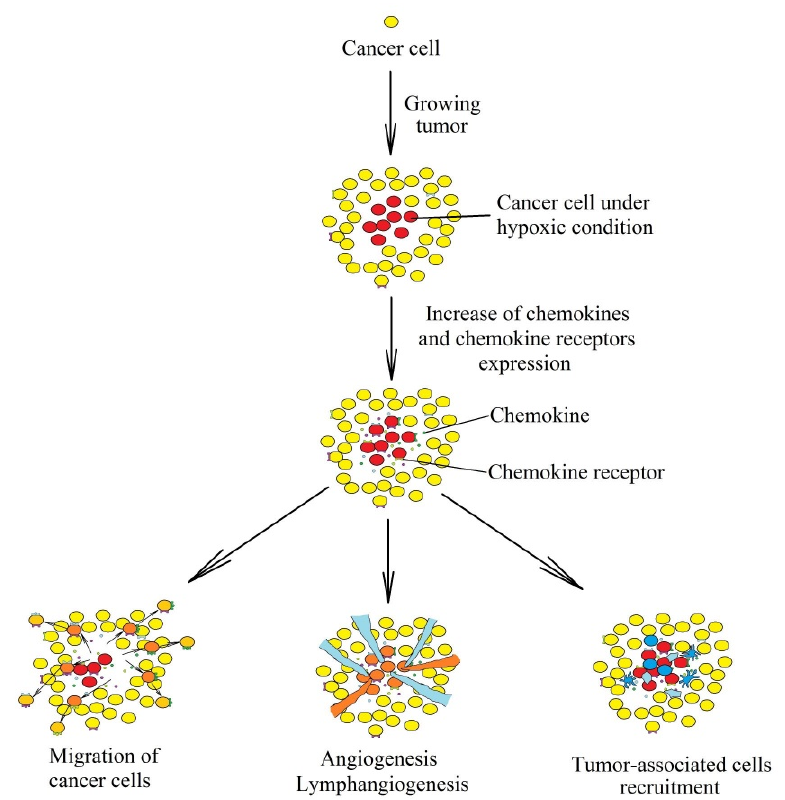
Figure 1. Consequences of the influence of hypoxia on the chemokine system in a tumor. A tumor or metastasis are initiated by a single cell that begins to divide uncontrollably. During the growth of the tumor, chronic hypoxia appears in the center of the tumor, which increases the concentration of chemokines in the tumor microenvironment and chemokine receptors on cancer cells. The activation of chemokine receptors on the cancer cell causes their migration. Chemokines cause angiogenesis, lymphangiogenesis, and recruitment of tumor-associated cells to areas with chronic hypoxia.